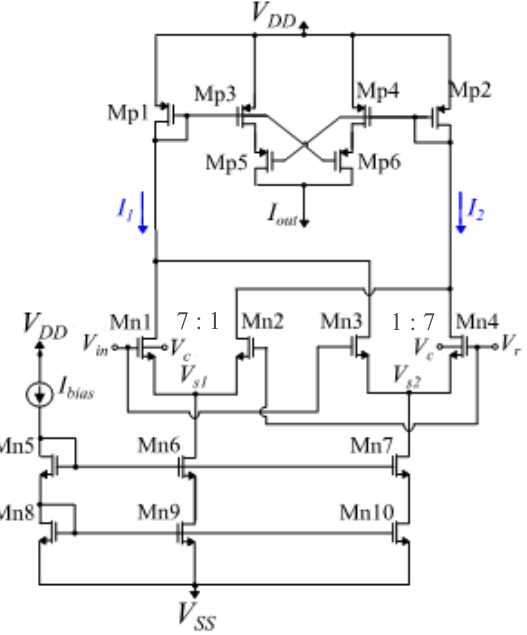
Figure 1. The utilized bump circuit. The parameter voltages V r , V c , and the bias current I bias control the Gaussian function’s mean value, variance, and peak value, respectively.